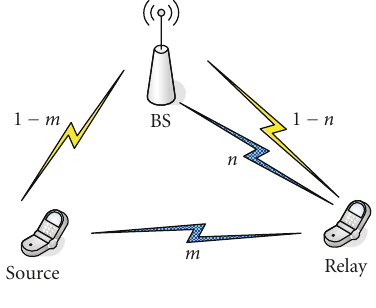
Figure 1: System